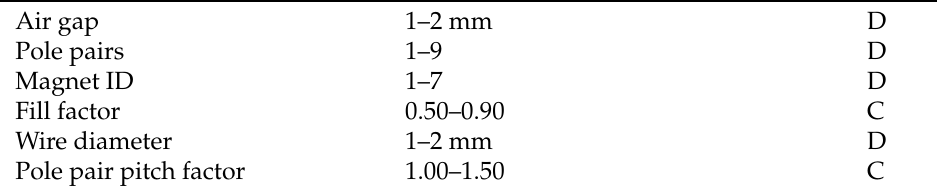
Table 4. Decision variables.